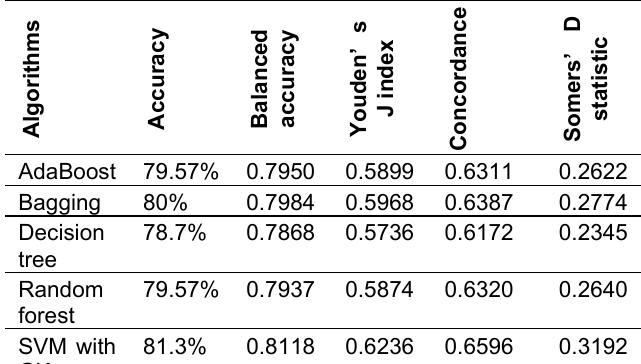
Table 5. Evaluation metrics of random forest